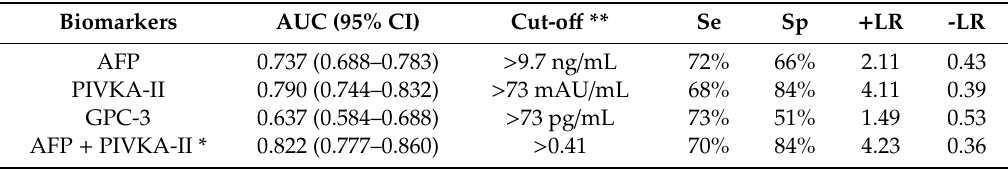
Table 3. Diagnostic accuracy of AFP, PIVKA-II, GPC-3 alone or in combination for the discrimination between patients with cirrhosis and those with HCC.